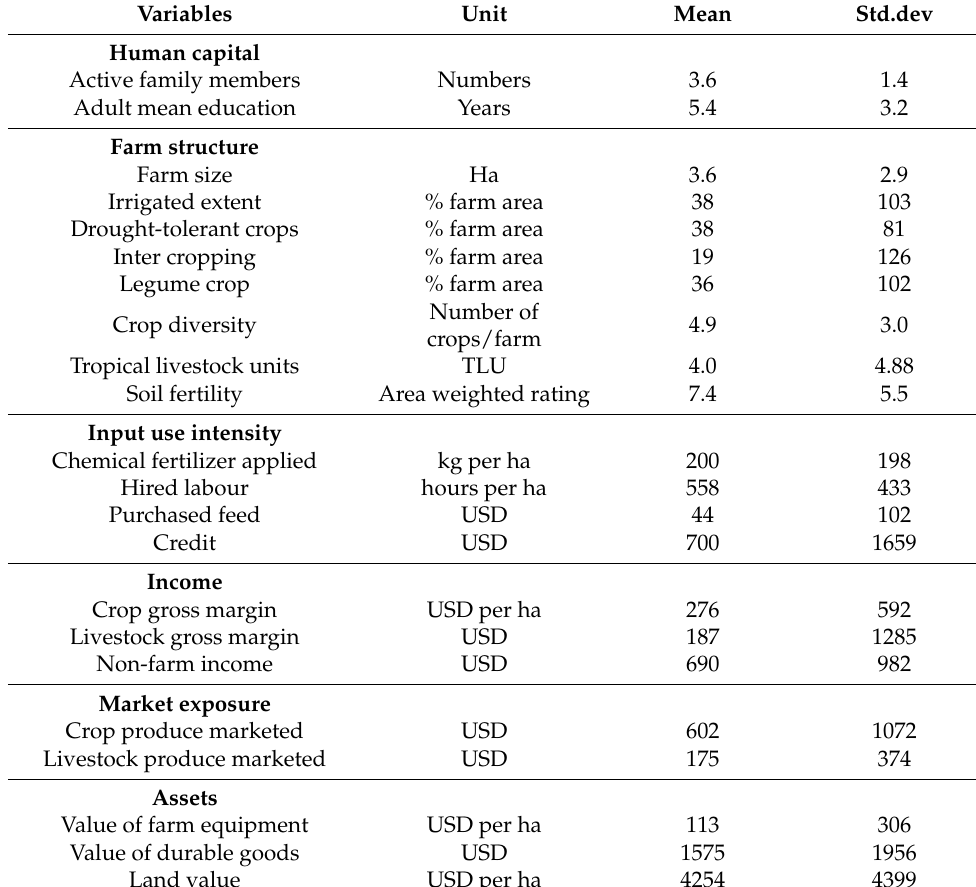
Table 3. Descriptive statistics of the parameters used for Multiple Factor Analysis